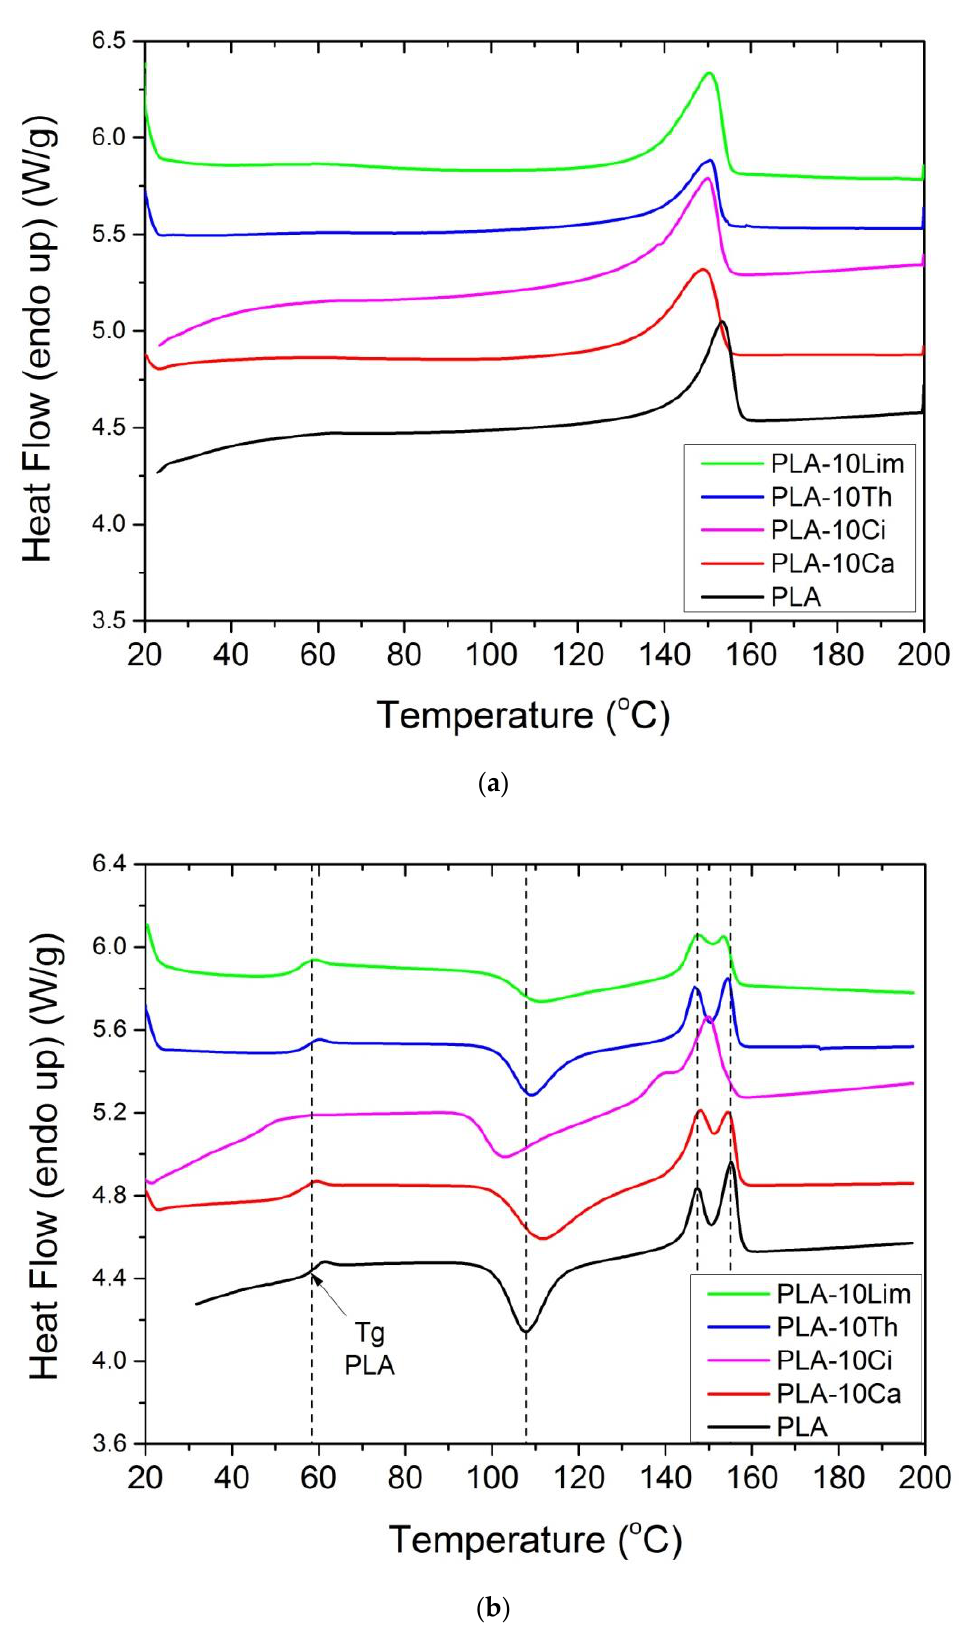
Figure 6. DSC measurements of PLA and their composites with 10 wt% thymol, carvacrol, limonene or cinnamaldehyde recorded during the first ( a ) or the second heating ( b ).